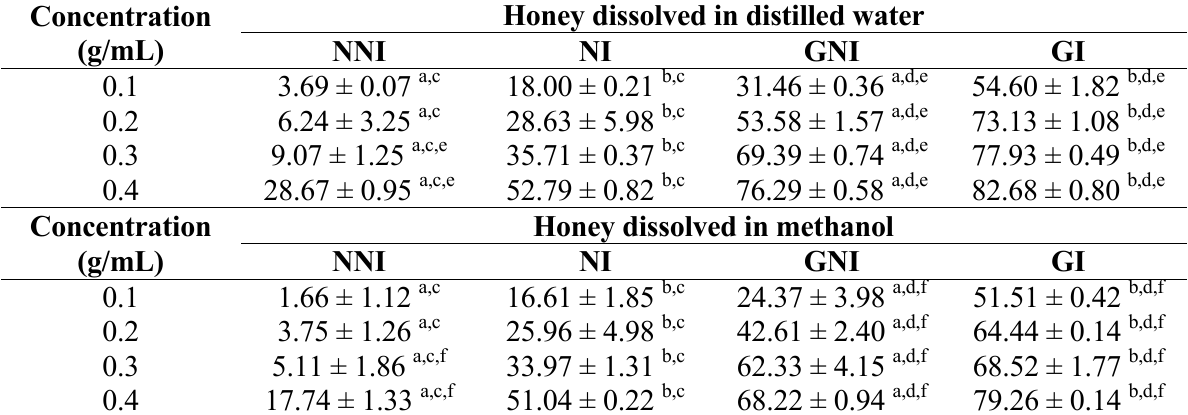
Table 2. Radical scavenging activity (% inhibition) of Gelam and Nenas honeys before and after